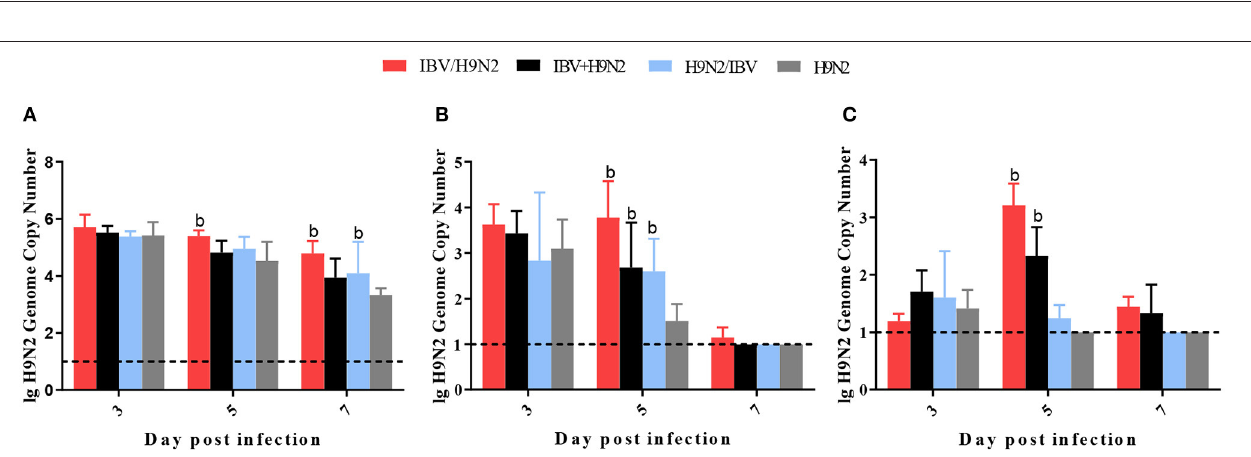
FIGURE 5 | Viral load of IBV in chickens. To compare viral replication, certain tissues, including samples from the trachea, lungs, and kidneys, were collected at 3, 5, and 7 dpi for virus titration using one-step RT-qPCR. (A) Trachea, (B) lungs, and (C) kidneys. Data are presented as means ± SD. “a” indicates a significant difference ( P < 0.05) between the three co-infection groups and the single-infection IBV group. Dashed black lines indicate the lower limit of detection. IBV, infectious bronchitis virus; RT-qPCR, quantitative reverse transcription polymerase chain reaction; SD, standard deviation.